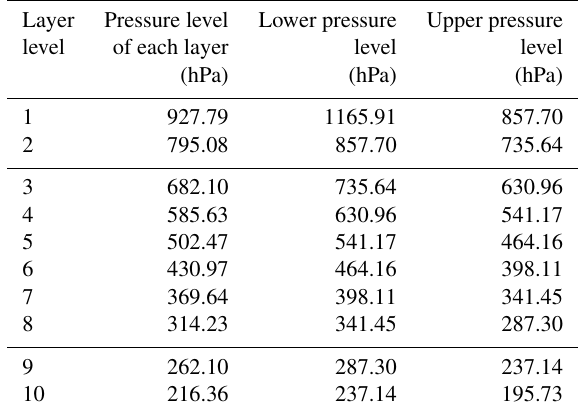
Table 1. Pressure levels of retrieval grid layers of GOSAT/TANSO- FTS TIR V1 L2 CO 2 data focused on in this study.